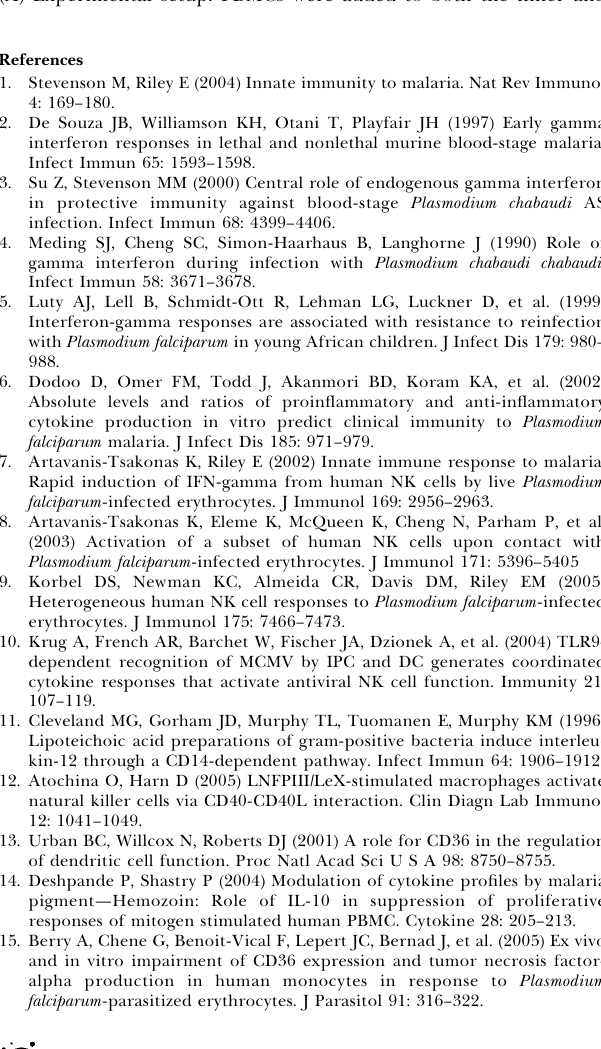
Figure S2. Staining with Isotype-Matched Control Antibodies Is Not Affected by Stimulation of Accessory Cells Representative histograms showing staining of monocytes with (A) IgG1 and (B) IgG2a antibodies following culture of PBMCs with no stimulation (gm), LPS, or iRBCs. (C) Pooled data for monocytes stained for IgG1 following culture with indicated stimuli. (D) Pooled data for monocytes stained for IgG2a following culture with indicated stimuli. No significant increase in staining intensity of either antibody was observed after stimulation with E. coli LPS or iRBCs. Figure S3. Effect of Blocking Antibodies on the NK Cell Response to iRBCs Representative FACS plots showing the effect on the NK cell response to iRBCs of blocking with monoclonal antibodies of the following specificities: (A) anti-IL-2, (B) anti-TGF- b , and (C) anti-IFN- a receptor. Figure S4. Up-Regulation of CD69 on NK Cells in Response to iRBCs Is Controlled by Type 1 IFN, IL-2, and TGF- b PBMCs from malaria-naı¨ve donors were stimulated for 24 h with iRBCs in the presence of increasing concentrations of neutralising antibodies to (A) the IFN- a / b receptor, (B) IL-2, (C) IL-15, or (D) TGF- b . MFI of CD69 on NK cells relative to that observed with the equivalent concentration of isotype-matched control antibody is shown. Figure S5. Diffusion of Soluble Factors through Transwell Membrane (A) Experimental setup. PBMCs were added to both the inner